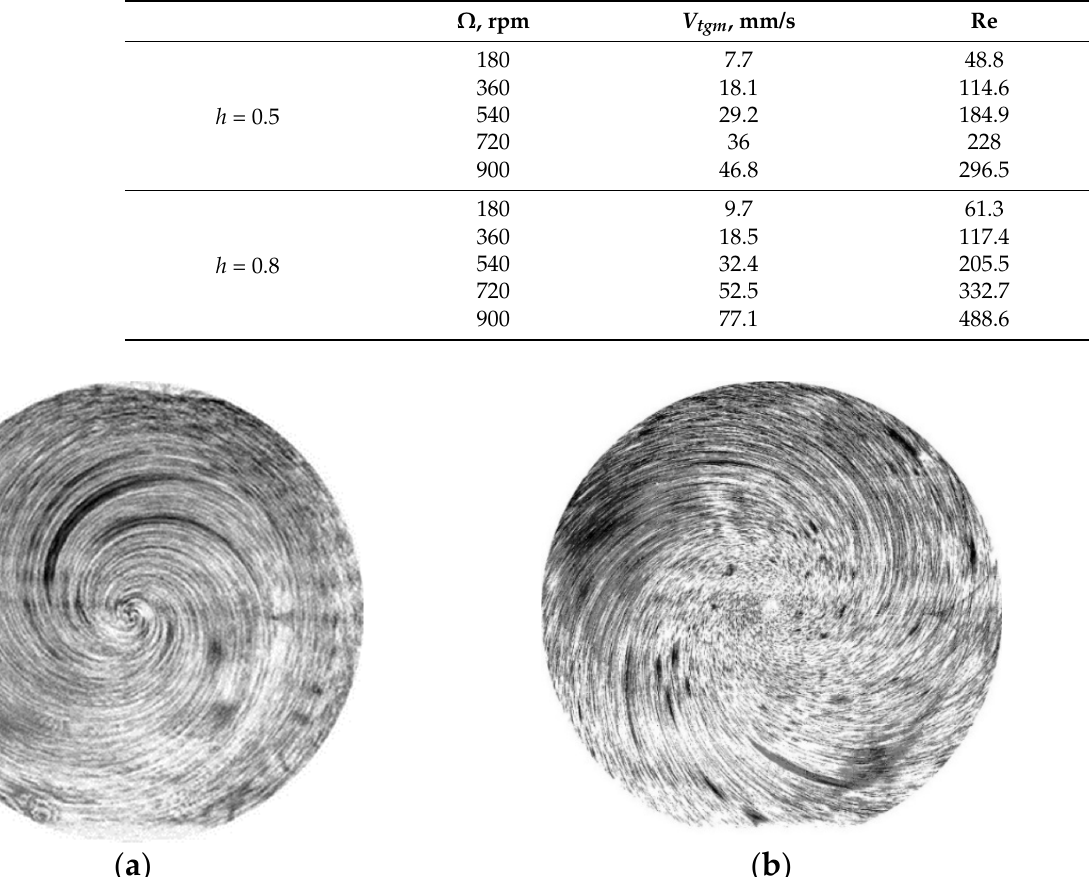
Figure 5. The streamlines reconstructed from the vector fields obtained in a horizontal section near the interface ( left —in air; right —in the working model fluid). At low Ω , there is a strongly converging flow in the air above the interface, where the centrifugal force acts on the medium adjacent to the swirler and meridional air circulation is observed, like in the case of the two ‐ liquid system. As Ω increases, a turbulent flow is formed in the air near the reactor axis; it appears as a diverging flow near the interface (Figure 4, left column). In the liquid, the processes occur according to the classical scenario of vortex interactions in two ‐ fluid systems [6,24,25]. At low Ω , a centrifugal cell of merid ‐ ional circulation arises near the axis, thus increasing its intensity with rising Ω . This